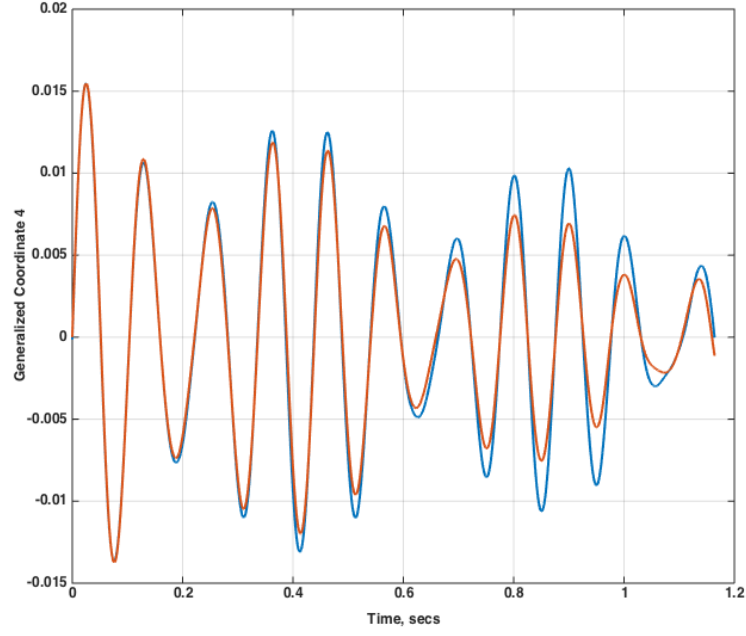
Figure 15. Aeroelastic response in mode 4 for the FUN3D (blue) and ROM (orange) solutions for the configuration including the